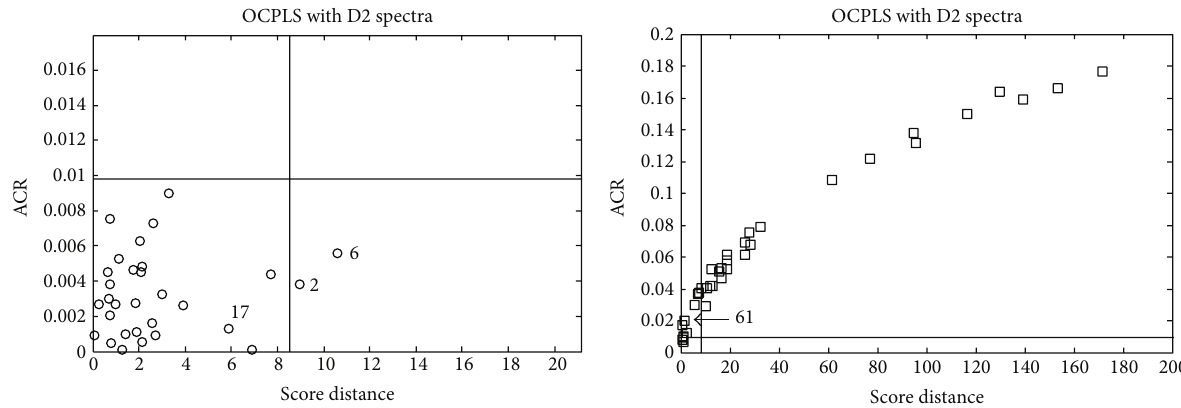
Figure 4: Prediction results of D2-OCPLS for PDO (objects 1–30, I ) and non-PDO (objects 31–67, ◻ ) objects.